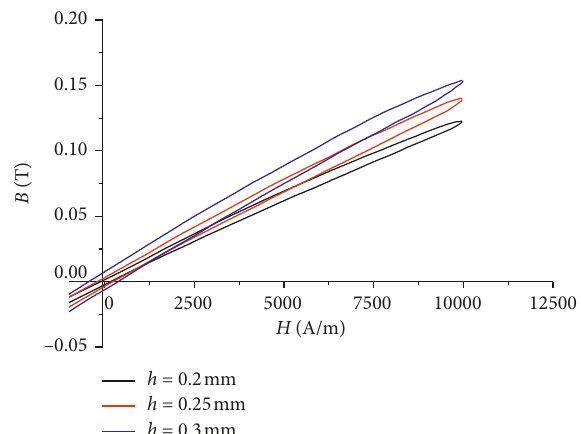
Figure 5: Loops shape for different thicknesses of paint layer.